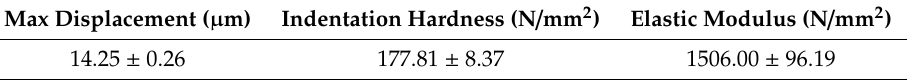
Table 3. Maximum displacement, indentation hardness and elastic modulus of PEV calculated by nanoindentation